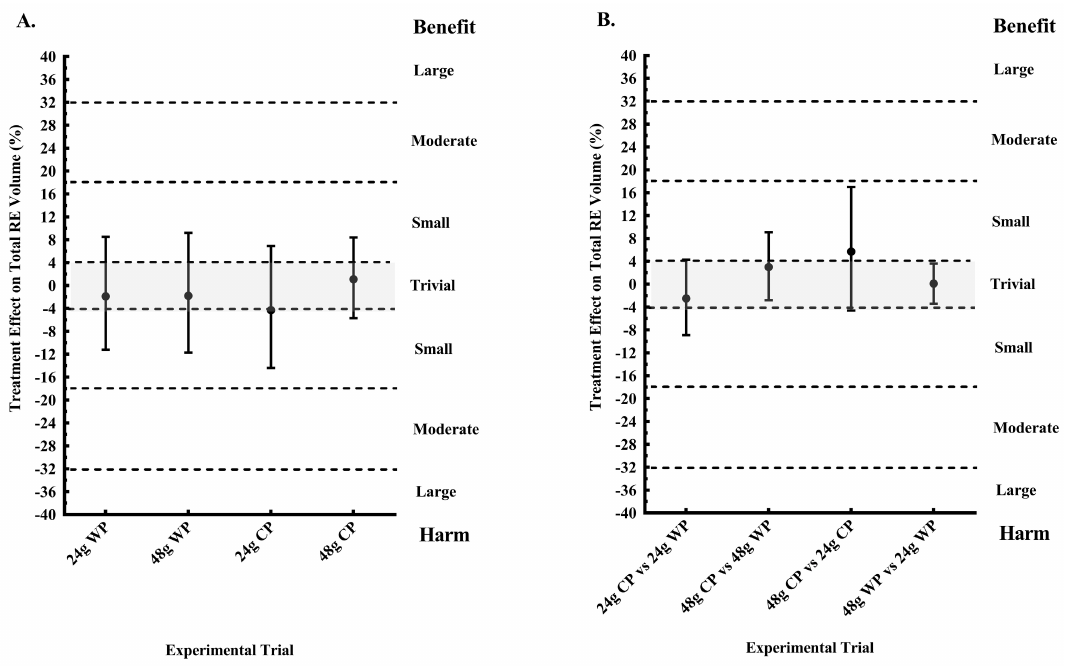
Figure 2. Treatment effects on total resistance exercise (RE) volume performed the morning after pre-sleep consumption of a single serving of 24 or 48 g whey protein (WP), 24 or 28 g casein protein (CP), compared ( A ) to a non-energetic placebo (PLA) and ( B ) other protein types and dose.